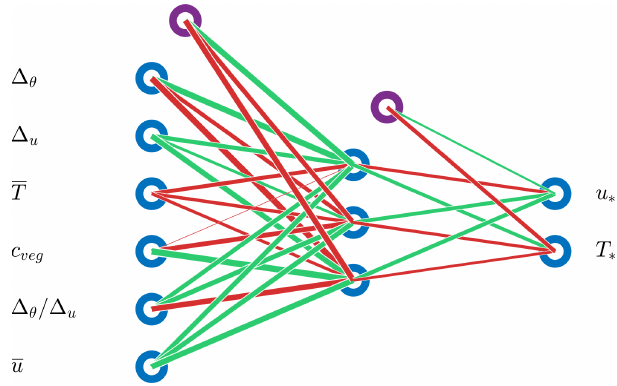
Table 7. Relative computational demand of the ANNs discussed in the text.